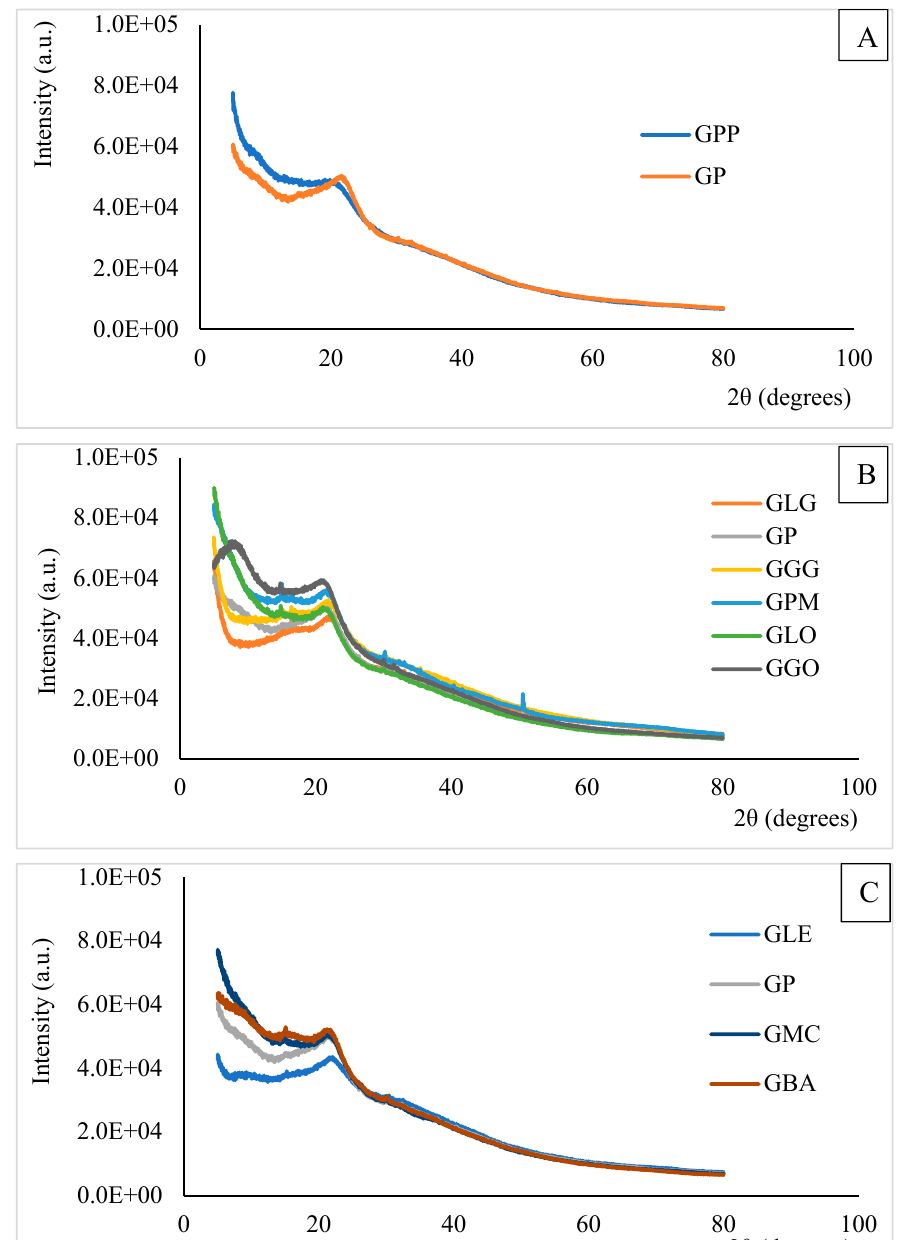
Figure 5. XRD patterns of control GP film and GPP film ( A ); of control GP film and films incorporated with plant oils ( B ); of control GP film and films incorporated with plant extracts ( C ).